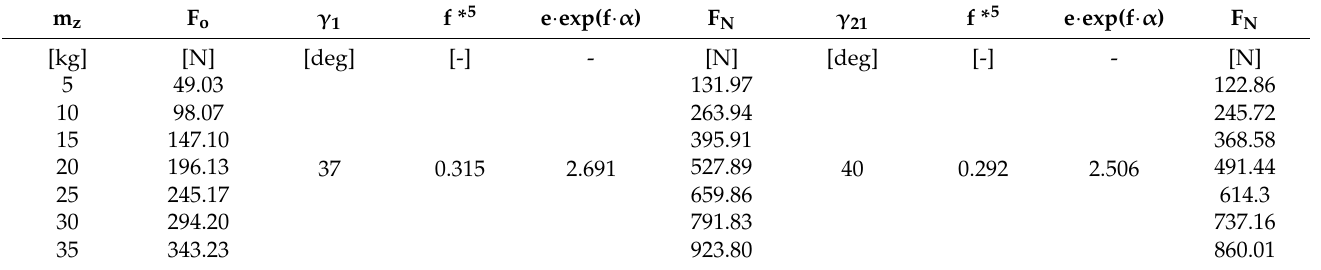
Table 8. Pulling forces in the sides of a cable running over a pulley groove for different groove angles.